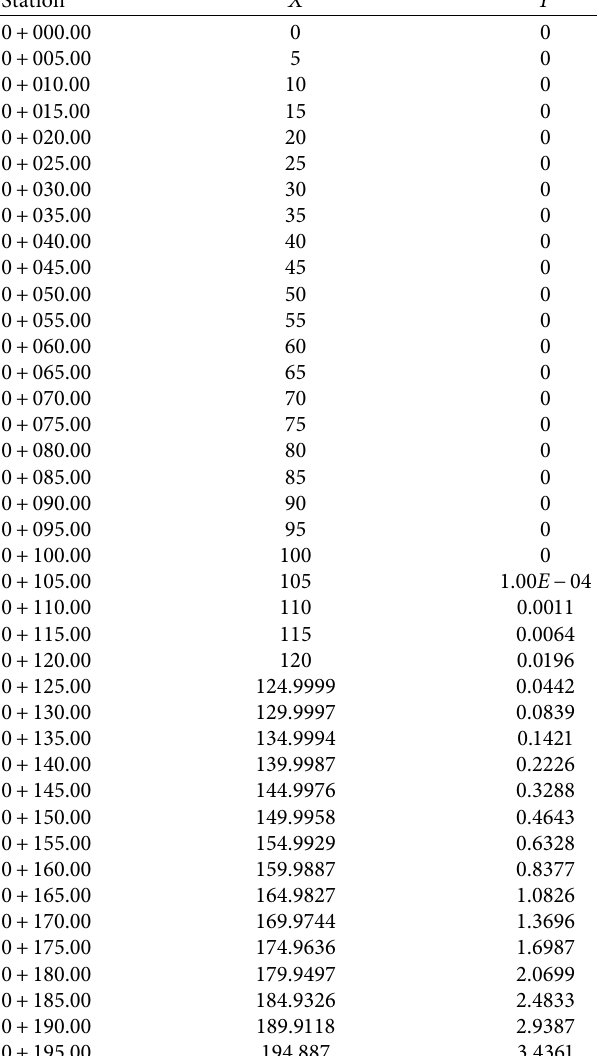
Table 1: Path points with the spiral curve.